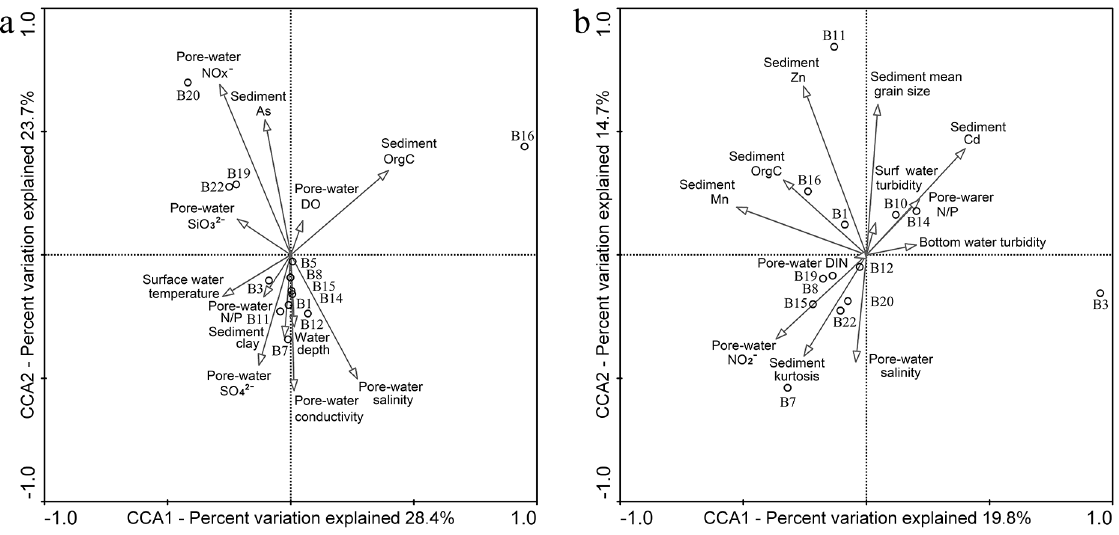
Figure 6. CCA ordination plots of the relationship between Bohai Sea sediment anammox bacterial assemblages and environmental factors. Only the first two principal dimensions of the CCA results were shown using the data of (a) the Ca . Scalindua 16S rRNA gene sequence OTUs and (b) the anammox bacteria Hzo sequence OTUs. Correlations between the Bohai Sea environmental factors and CCA axes are represented by the length and angle of arrows (environmental factor vectors). Covarying environmental variables (defined as r $ 0.950), such as surface seawater salinity and EC25 ( r =0.994) and bottom seawater salinity and EC25 ( r =0.958), were checked to minimize collinearity in the analyses.